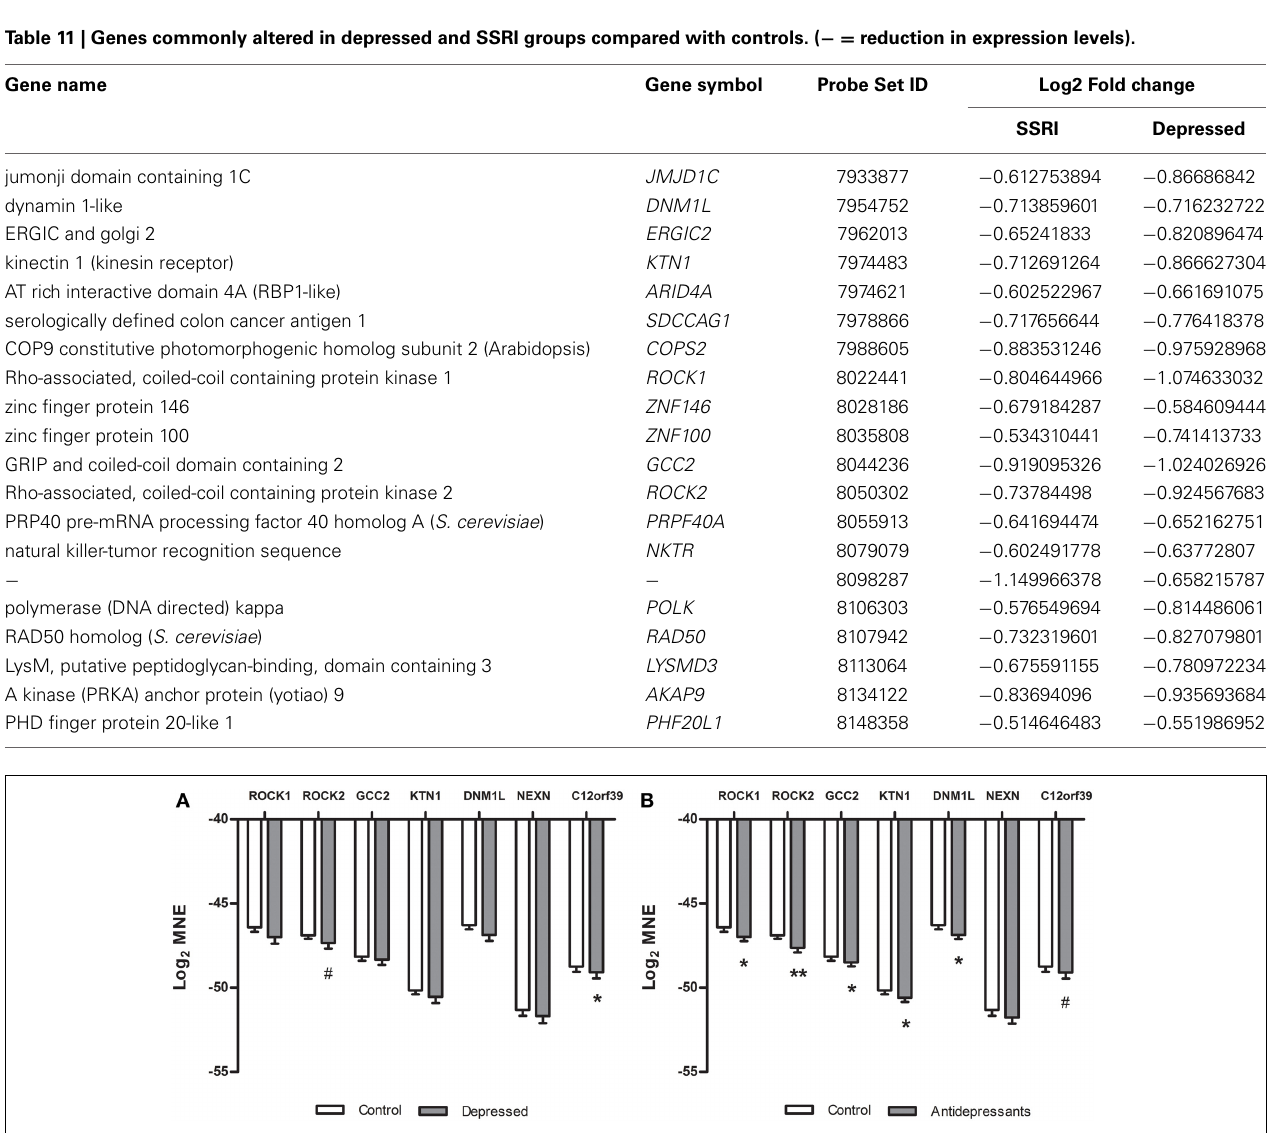
FIGURE 2 | Differences in gene expression (qPCR) between subsets in the validation study of the microarray data. Log2 mean normalized expression (MNE) is shown for the ROCK1, ROCK2, GCC2,